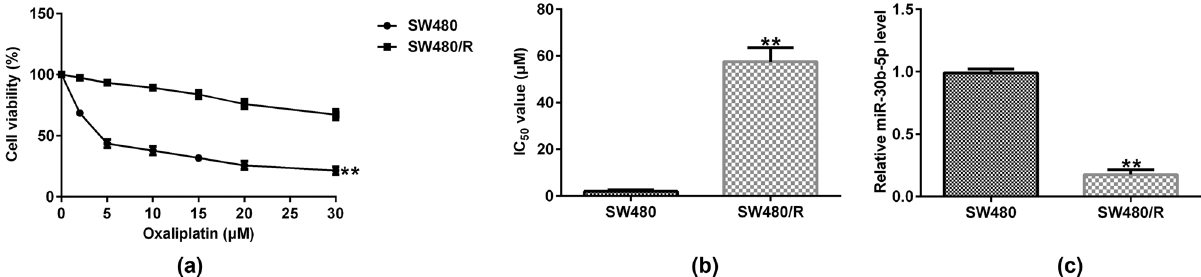
Figure 1: miR - 30b - 5p expression is downregulated in SW480/R cells. ( a ) MTT assay was performed to assess cell viability. ( b ) IC 50 value of di ff erent cells. ( c ) RT - qPCR analysis of miR - 30b - 5p expression level. Data are represented as the mean value ± SD of three independent experiments. ** P < 0.01 vs SW480 cells.